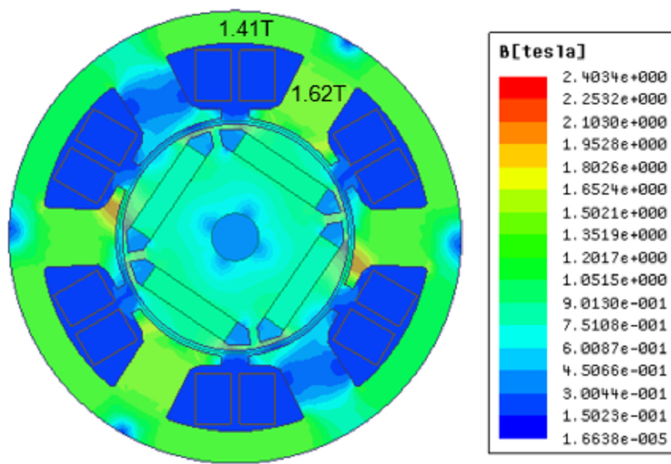
Figure 18. Magnetic flux distribution within the proposed magnetic structure: hot magnetic spot.